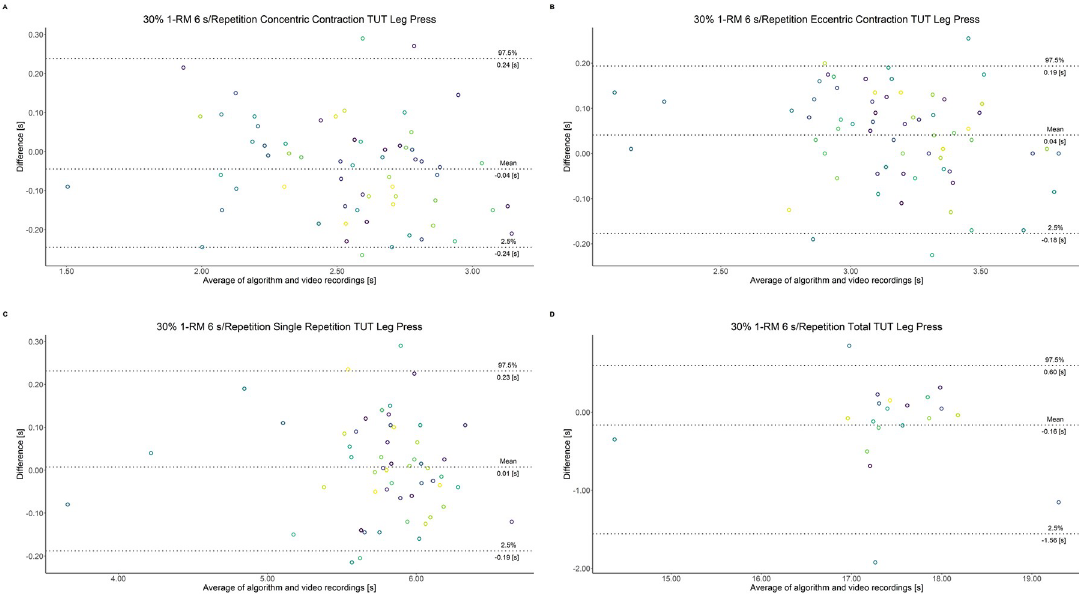
Fig 9. Bland-Altman plots of agreement between algorithmically accelerometer derived and video recordings derived contraction- specific phases of the leg press machine at 30% 1-RM with a velocity of 6 s per repetition. A: Concentric contraction phase. B: Eccentric contraction phase. C: Single repetition. D: Total time-under-tension.